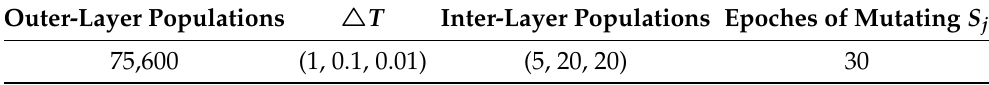
Table 3. The configuration of the proposed